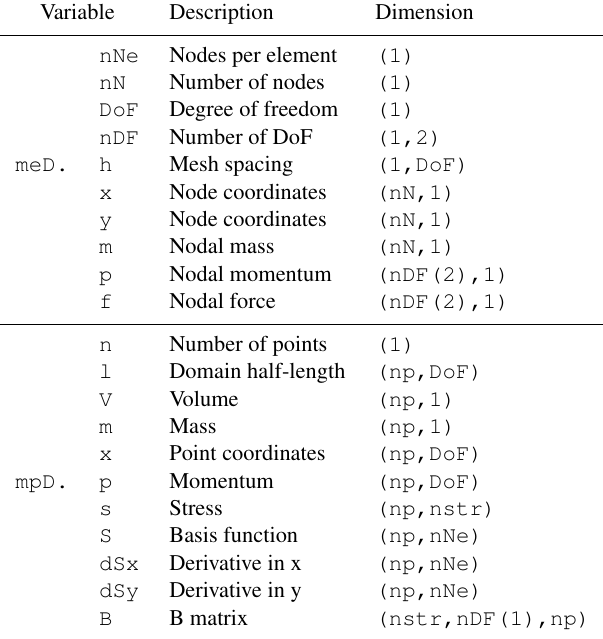
Table B1. Variables of the structure arrays for the mesh meD and the material point mpD used in code fragments 1 and 2 shown in Figs. 4 and 5. nDF stores the local and global number of de- grees of freedom, i.e. nDF=[nNe,nN*DoF] . The constant nstr is the number of stress components, according to the standard def- inition of the Cauchy stress tensor using the Voigt notation,